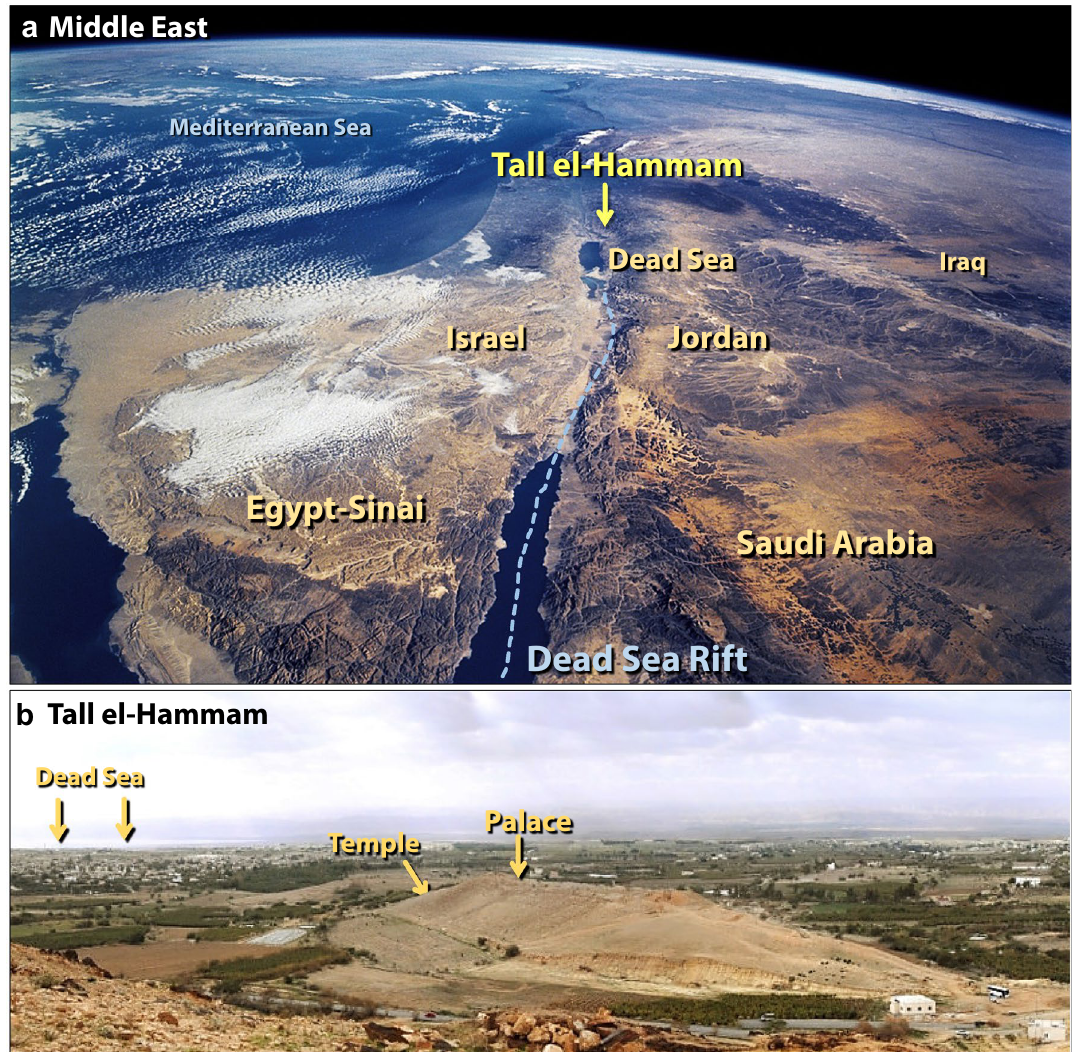
Figure 1. Location of Tall el-Hammam. ( a ) Photo of the southern Levant, looking north, showing the Dead Sea, the site location (TeH), and nearby countries. The Dead Sea Rift, the fault line marking a major tectonic plate boundary, runs through the area. Source of base image: NASA, Space Shuttle. “The Sinai Peninsula and the Dead Sea Rift”. Photo: sts109-708-024, taken 12/16/2009. From the NASA Langley Research Center Atmospheric Science Data Center (nasa.gov/topics/earth/features/astronauts_eyes/sts109-708-024.html). Modified by the authors using Adobe Photoshop CC2014 (adobe.com/products/photoshop.html). ( b ) West- southwest-facing view of the upper tall showing locations of the palace and temple behind the curve of the upper tall. The Dead Sea is in the background to the